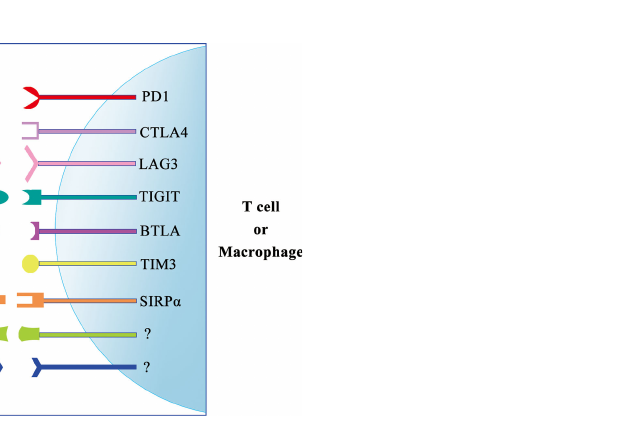
FIGURE 2 | Schematic diagram of the immune checkpoint receptor and its